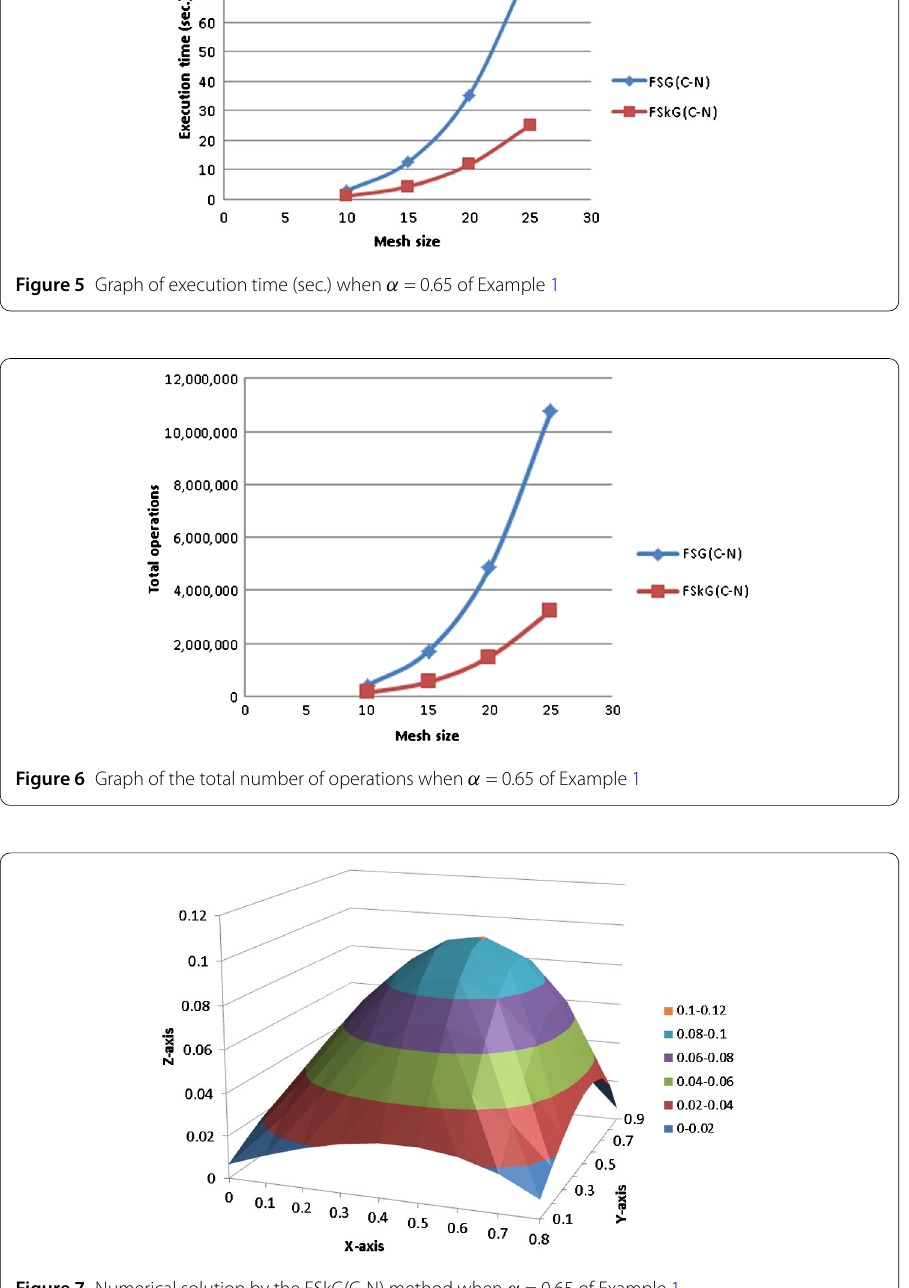
of calculated values of elapsed time (in seconds), number of iterations (Ite), maximum absolute error (Max Error), average absolute error (Ave Error), and the total number of arithmetic operations (Total Operations) by both FSG(C-N) iterative and FSkG(C-N) it- erative schemes when α = 0.60,0.70,0.80. The numerical results show that the FSkG(C-N) iterative method has (29.70 – 39.50) % less computational complexity than the